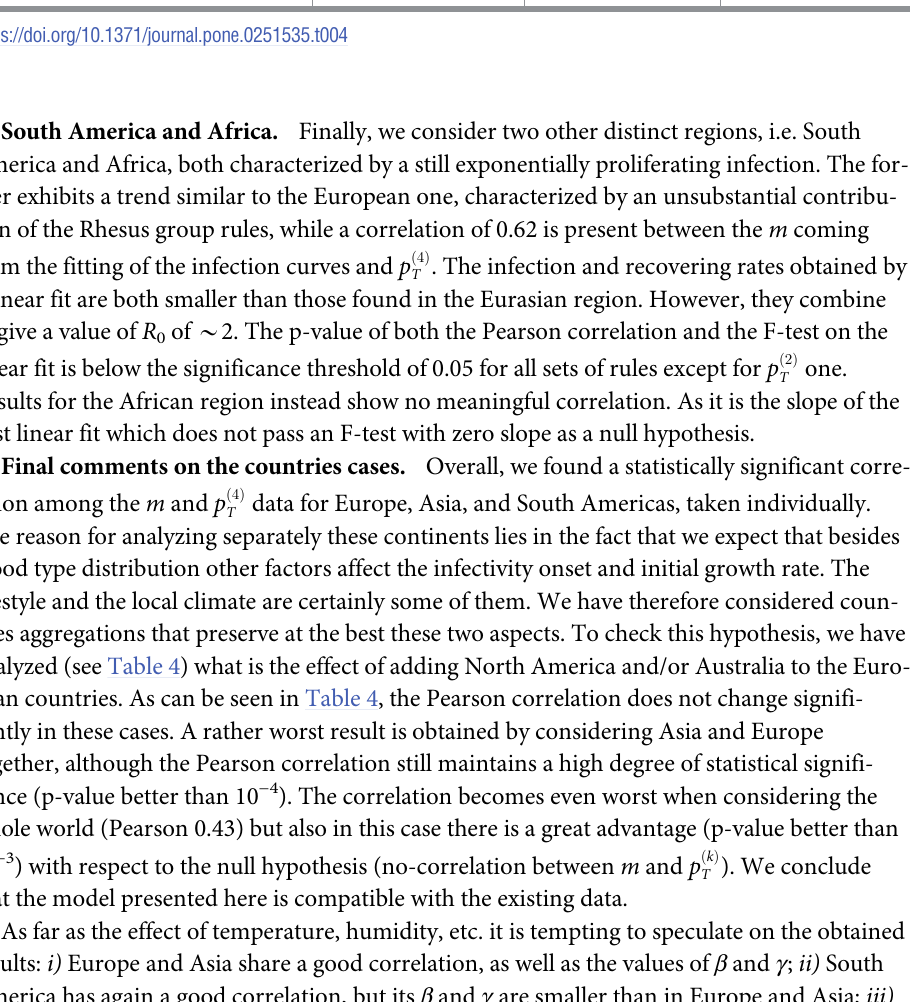
Table 4. Pearson correlations between m and p ð 4 Þ